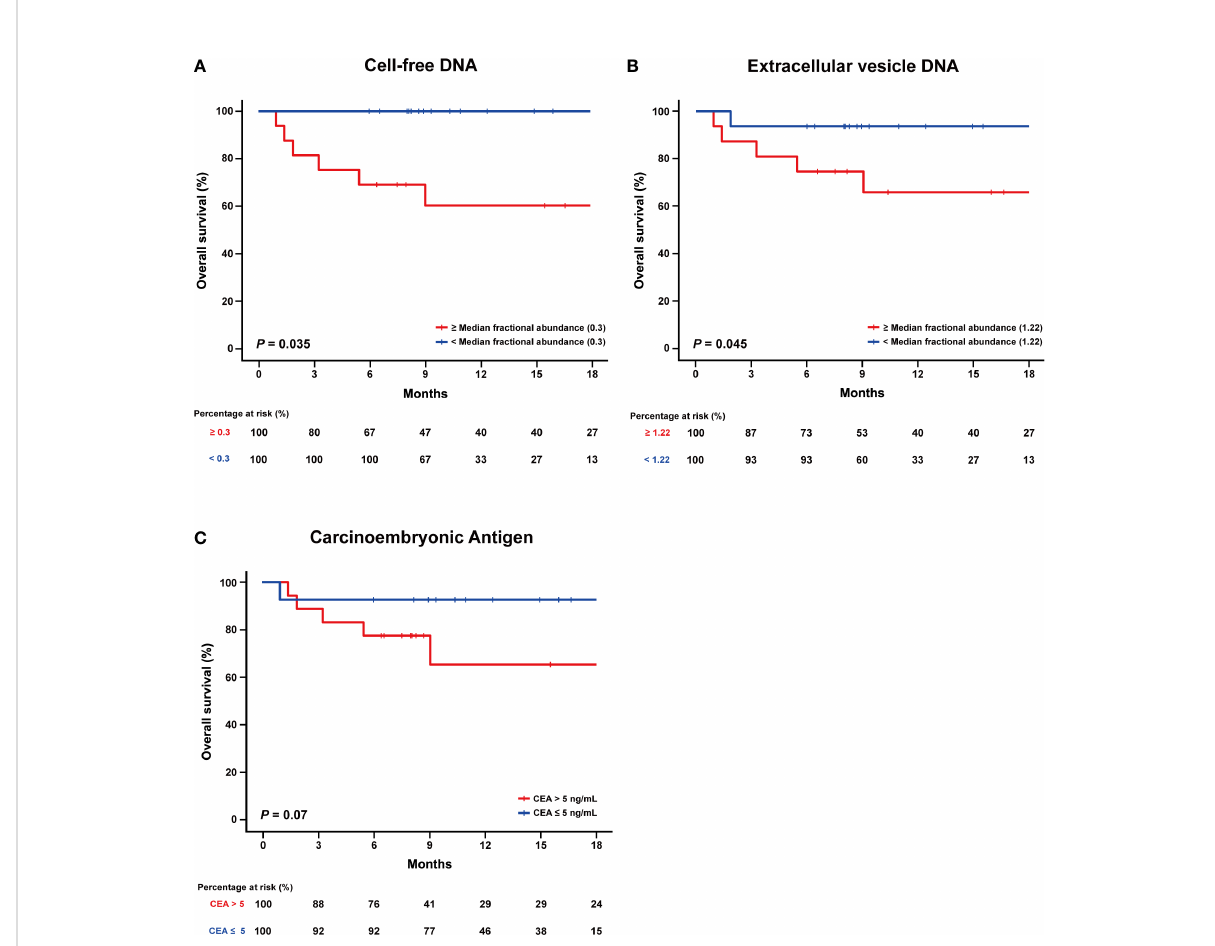
FIGURE 4 Comparing fractional abundance of cell-free DNA and extracellular vesicle DNA with overall survival (OS). (A) Kaplan-Meier curve of the overall survival (OS) divided according to low and high fractional abundance derived from cell-free DNA. (B) Kaplan-Meier curve of the overall survival (OS) divided according to low and high fractional abundance derived from extracellular vesicle DNA. (C) Kaplan-Meier curve of the overall survival (OS) according to CEA